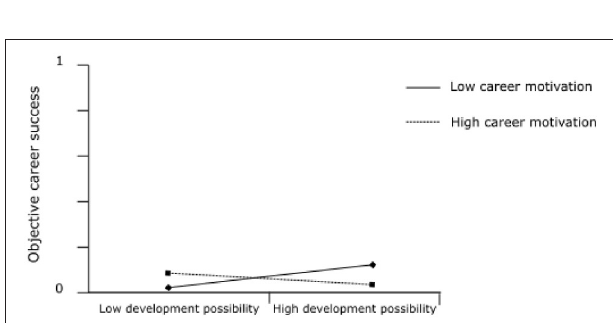
FIGURE 3 | The interaction of career motivation and development possibilities in predicting objective career